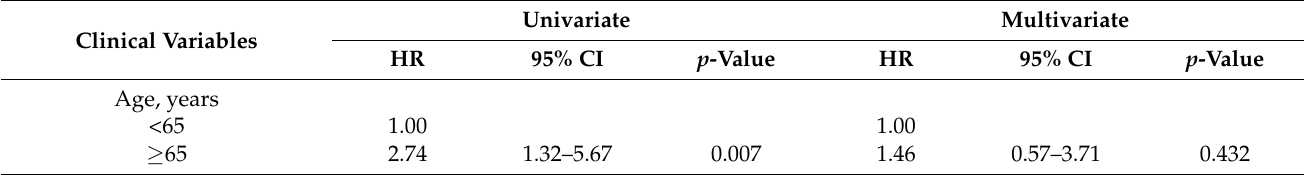
Table 2. Risk factors for diffuse large B cell